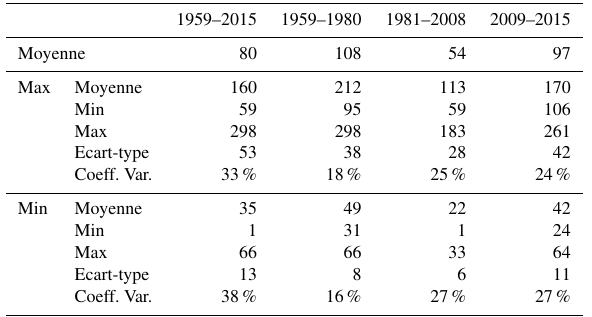
Figure 5. Chronique des débits modaux ( Q 0) moyens glissant sur 3 années à la station d’Azzaba, 1960–2015. Tableau 2. Synthèse sur la ressource en eau dans le bassin du Haut